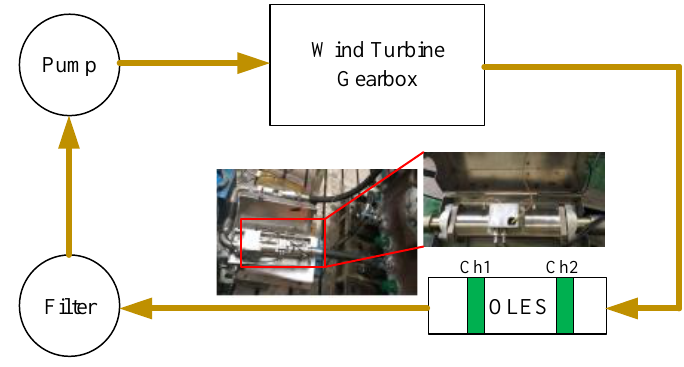
Figure 8. OLES installation diagram.